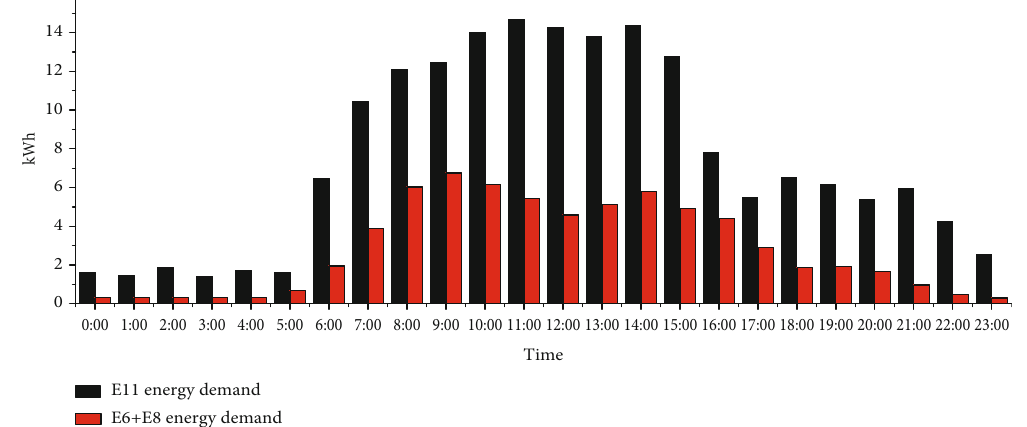
Figure 2: Predicted hourly energy demand in project site with PV ∗ Sol Premium.